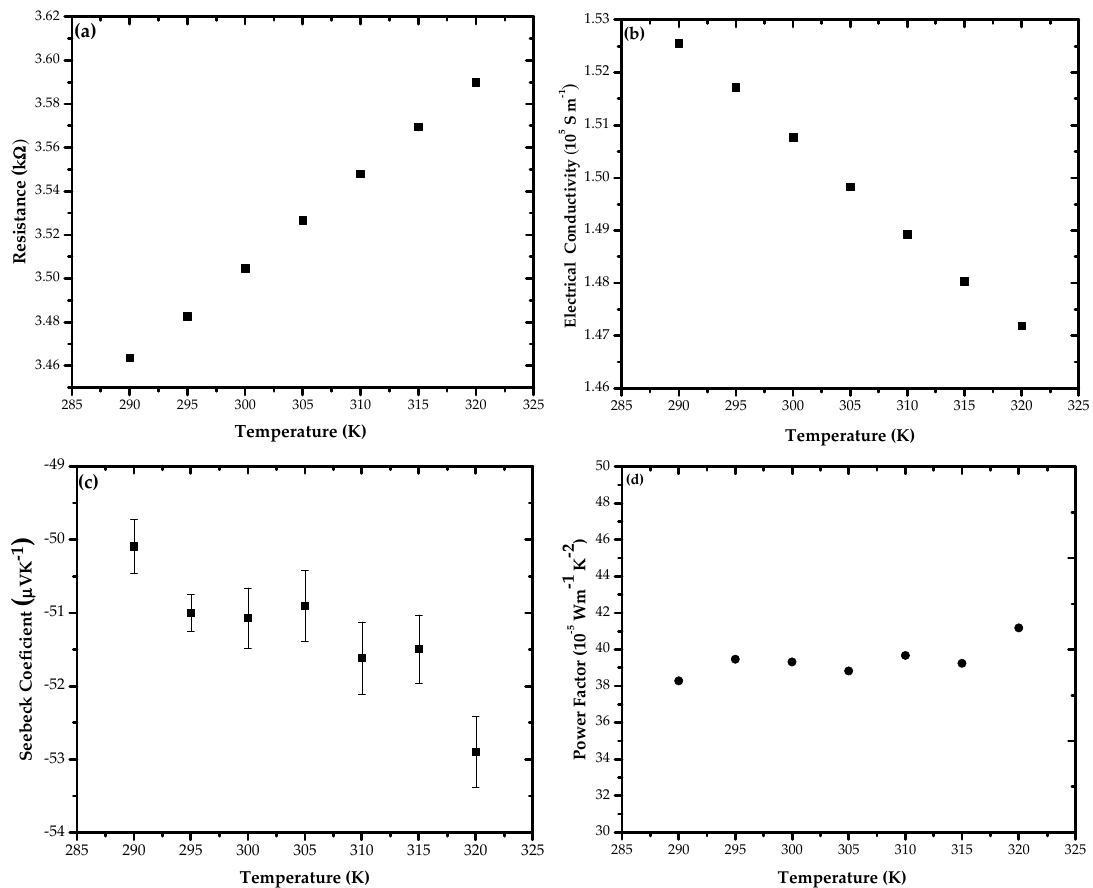
Figure 3. Temperature dependence regarding the ( a ) electrical resistance, ( b ) electrical conductivity, ( c ) TE power ( S ) and ( d ) power factor of the single-crystal Bi 2 S 3 NW.